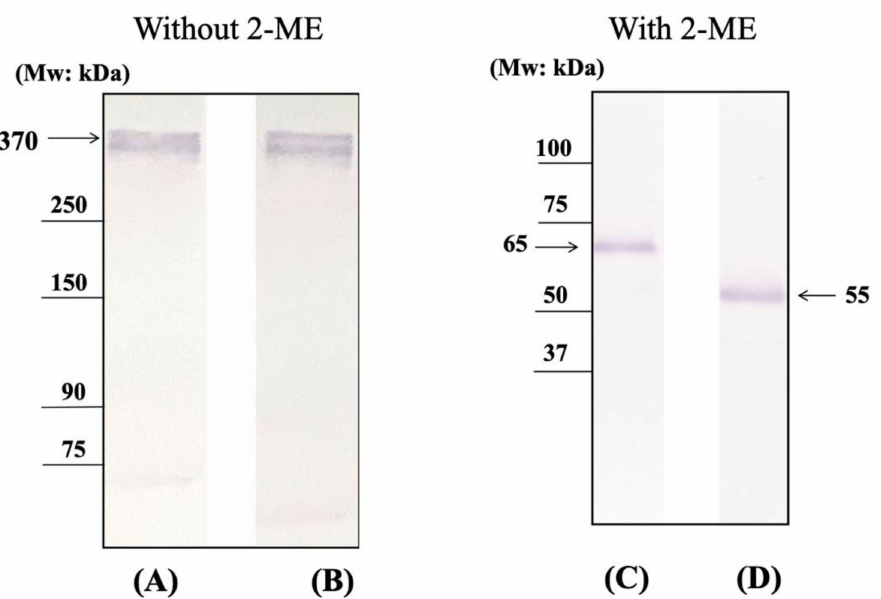
Figure 2. Western blot analysis of the purified IgA-albumin complex. IgA-albumin complexes were analyzed by SDS-PAGE and immunoblotted using anti-albumin (lanes A , C ) and anti-IgA ( α chain) (lanes B , D )